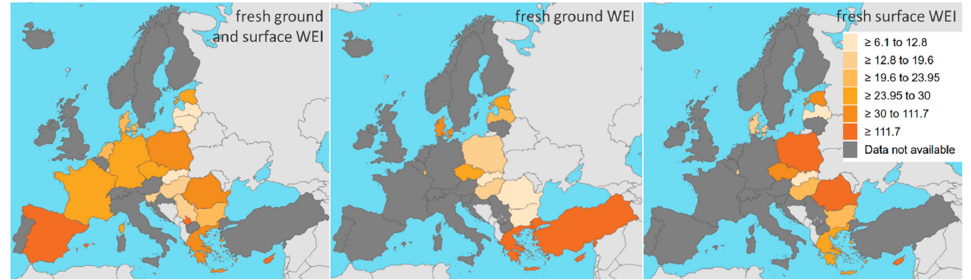
Figure 1. Europe Water Exploitation Index for overall fresh groundwater and surface water, fresh ground and fresh surface water for 2016 (Source: ec.europa.eu/eurostat) .